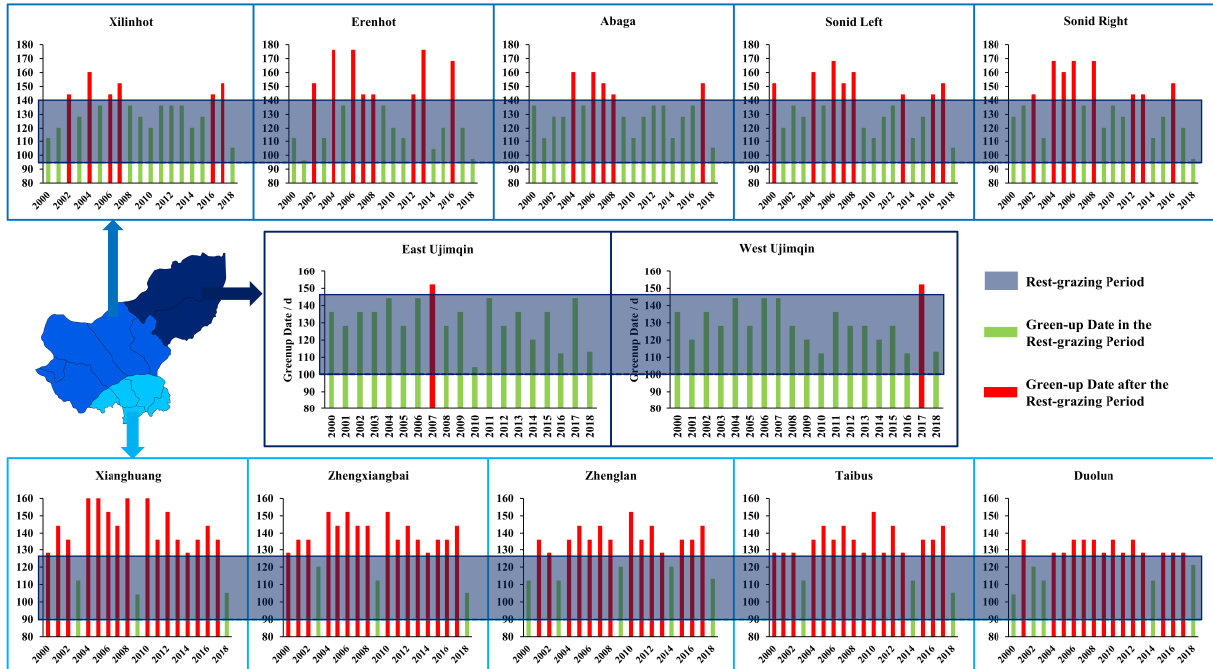
Figure 7. ( a ) Temporal variations of ( a ) precipitation, ( b ) temperature and ( c ) solar radiation; correla- tion between the ( d ) precipitation, ( e ) temperature and ( f ) solar radiation in April with the green-up date; spatial variations of ( g ) precipitation, ( h ) temperature and ( i ) solar radiation in April in Xilin Gol